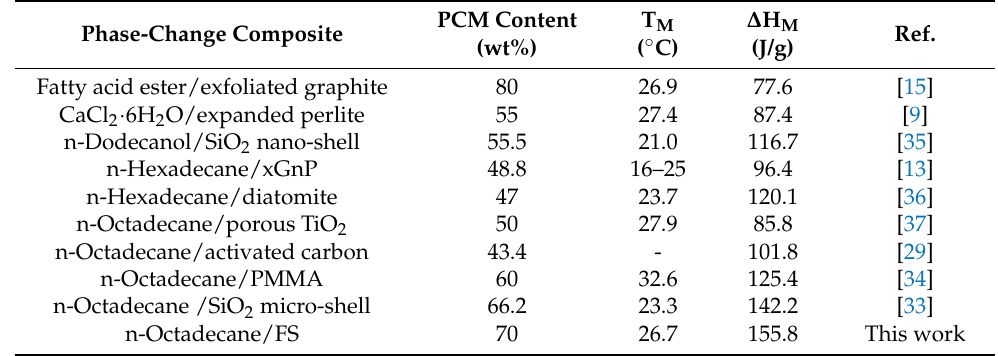
Table 2. Comparison of phase-change material (PCM) content and latent heat storage capacity of reported PCCs and the n-octadecane/FS